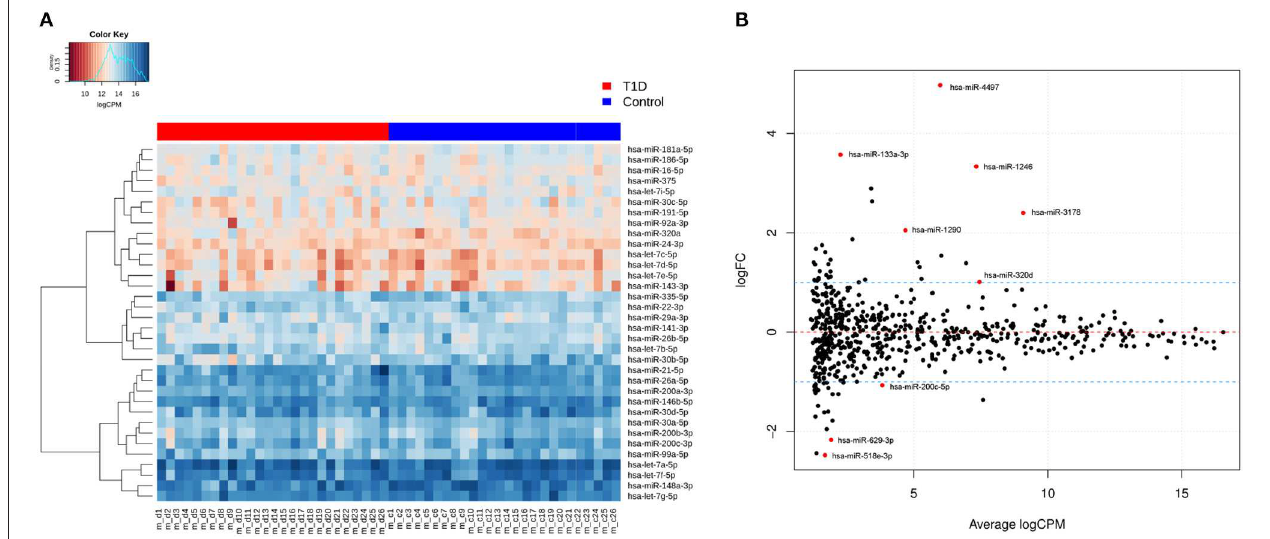
FIGURE 1 | Expression profiles of known miRNAs in human breast milk. (A) Heatmap of expression profiles (logCPM) of top 35 highly expressed miRNAs in both type 1 diabetes and control libraries based on hierarchical clustering. (B) Differentially expressed miRNAs in type 1 diabetes vs. controls based on log2FC ≥ abs (1) and adj. p -value < 0.05. A total of 9 differentially expressed miRNAs are shown in above plot. The dotted blue lines represent the log2FC cutoff.